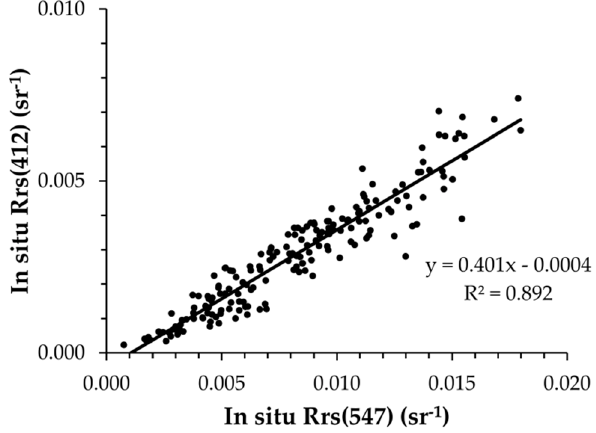
Figure 4. Relationship between in situ Rrs(412) and Rrs(547) used to improve the retrieval of MODIS Rrs(412).